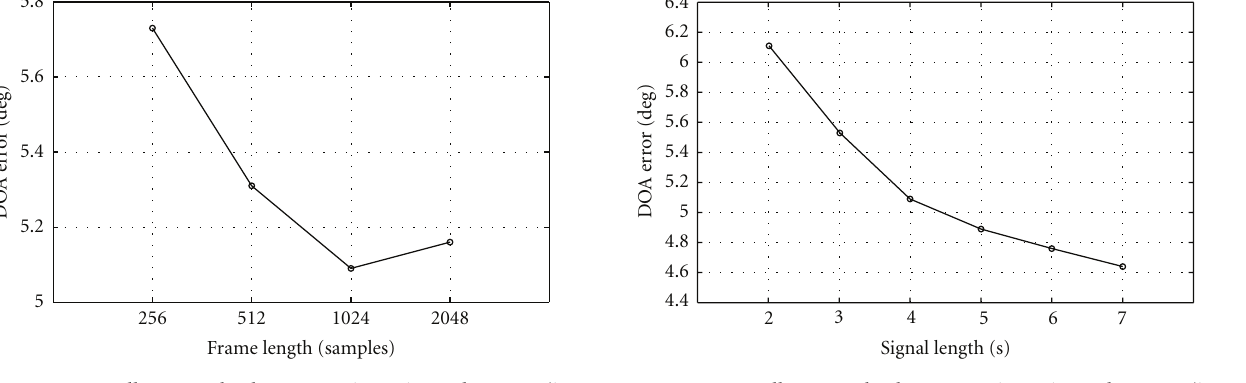
Figure 6: Overall mean absolute error in estimated DOAs (in degrees) obtained by the proposed algorithm as a function of the length of the signal when two microphones are used and three sources are